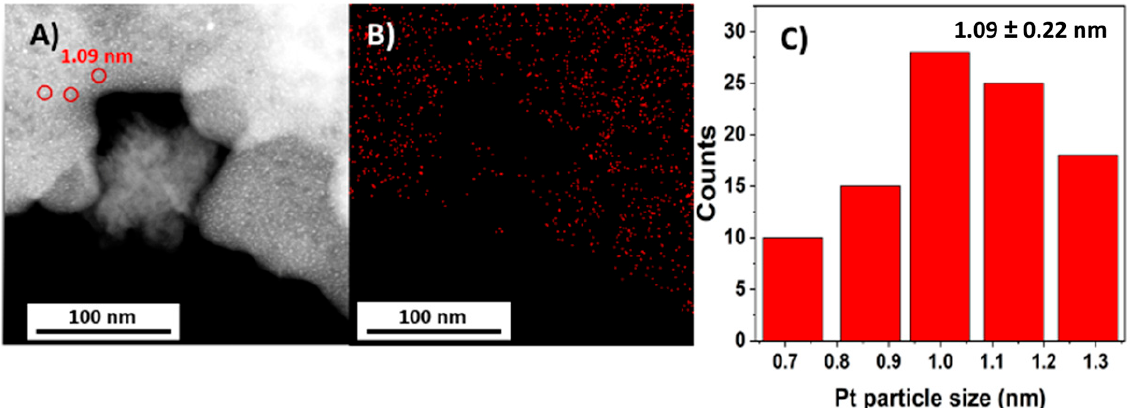
Figure 2. ( A ) STEM image by high-angle annular dark-field mode (HAADF-STEM), ( B ) STEM image with EDS mapping for Pt (red dot color represents Pt particles), and ( C ) Pt particle size distribution of Pt@SiNS(one).